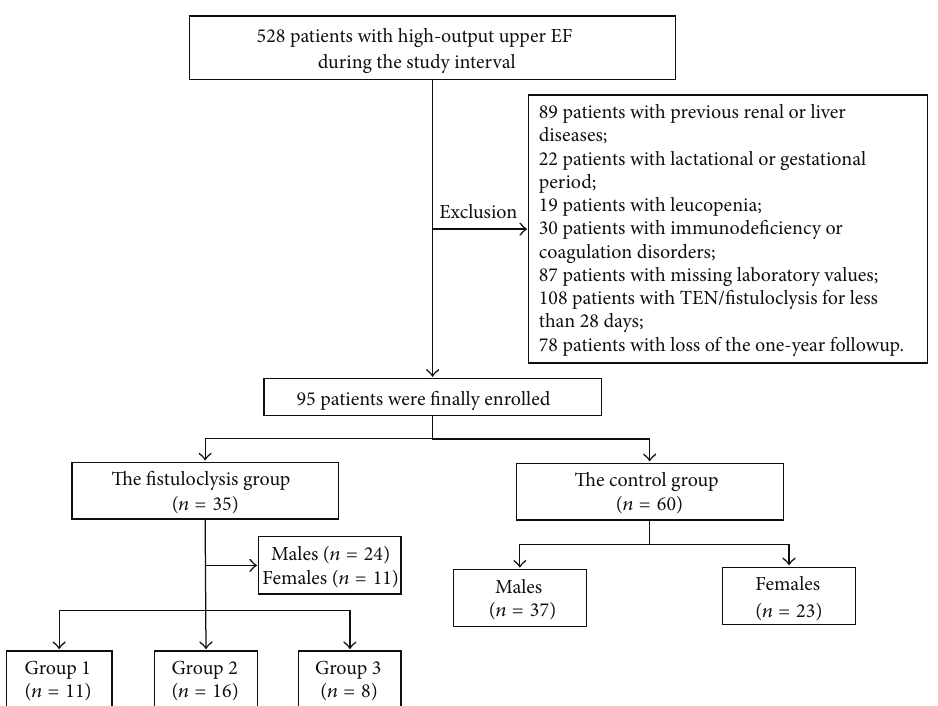
Figure 1: Flow chart of the study design. A total of 528 patients were enrolled during the interval of this study. According to the exclusion criteria, 95 patients were eligible and finally enrolled. Patients were assigned into the fistuloclysis group ( 𝑛 = 35 , receiving fistuloclysis plus total enteral nutrition (TEN)) and the control group ( 𝑛 = 60 , receiving TEN only). The fistuloclysis group was divided into subgroups according to EF locations: Group 1: patients with small intestinal fistula ( 𝑛 = 11 ); Group 2: patients with biliary fistula ( 𝑛 = 16 ); Group 3: patients with duodenum fistula ( 𝑛 = 8